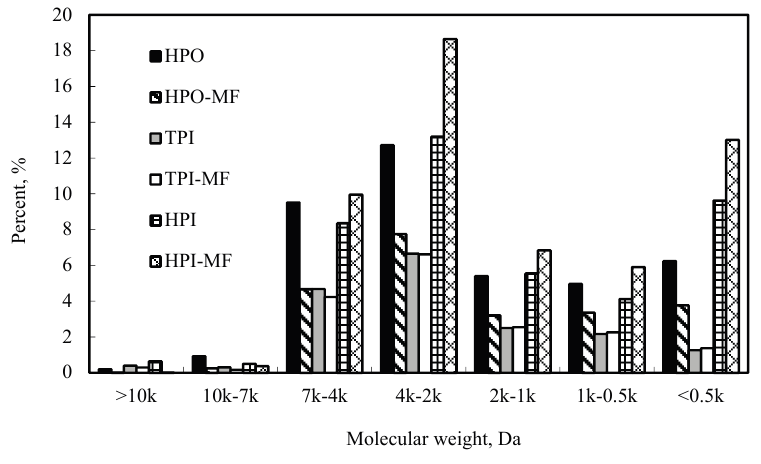
Figure 6. Change of organic hydrophobicity/hydrophilicity for raw water filtrated membrane filtration.